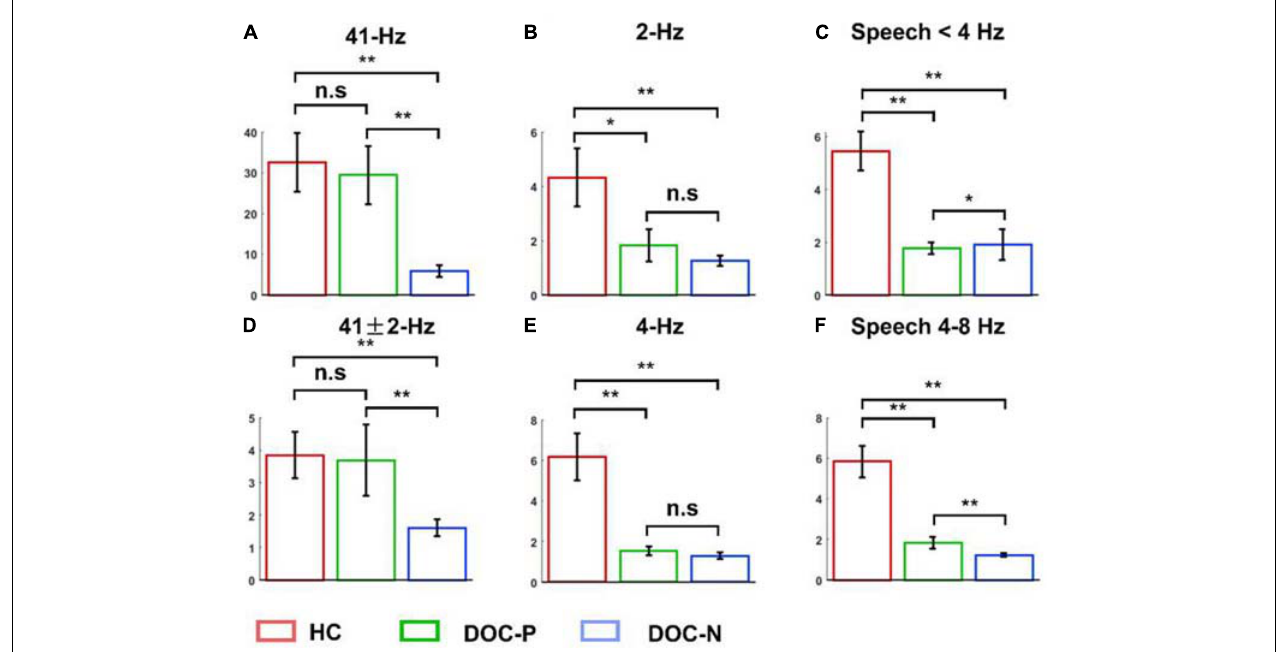
FIGURE 3 | Mean and SEM of the phase coherence between neural responses and acoustic envelope in the healthy controls (HC), patients with positive prognosis (DOC-P), and patients with negative prognosis (DOC-N). (A,D) There were no statistically significant differences in the 41 and 41 ± 2 Hz phase coherences between for HC and DOC-P. However, the 41 and 41 ± 2 Hz phase coherences were significantly higher in HC and DOC-P groups compared with those for DOC-N group. (B,E) The 2 and 4 Hz phase coherences in HC were significantly higher compared with those for DOC-P. (C,F) Phase coherences to natural speech in theta and delta bands were significantly different between HC and DOC-P groups (* P < 0.05, ** P < 0.01; n.s., not significant).